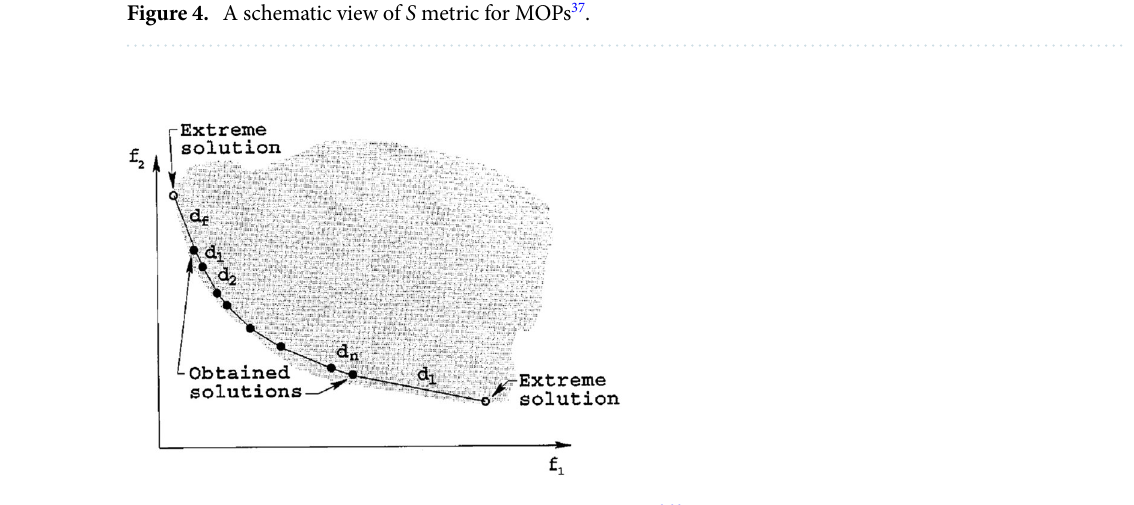
Figure 5. Schematic view of metric of spread (Δ) for MOPs 2,38